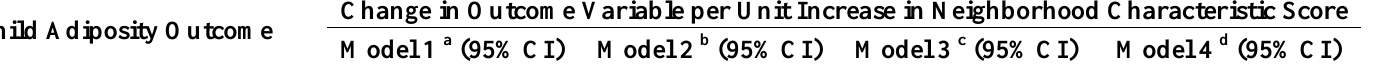
Table 2. Mixed model analyses for relationships between each neighborhood characteristic and child BMI, percent body fat and waist-to-height